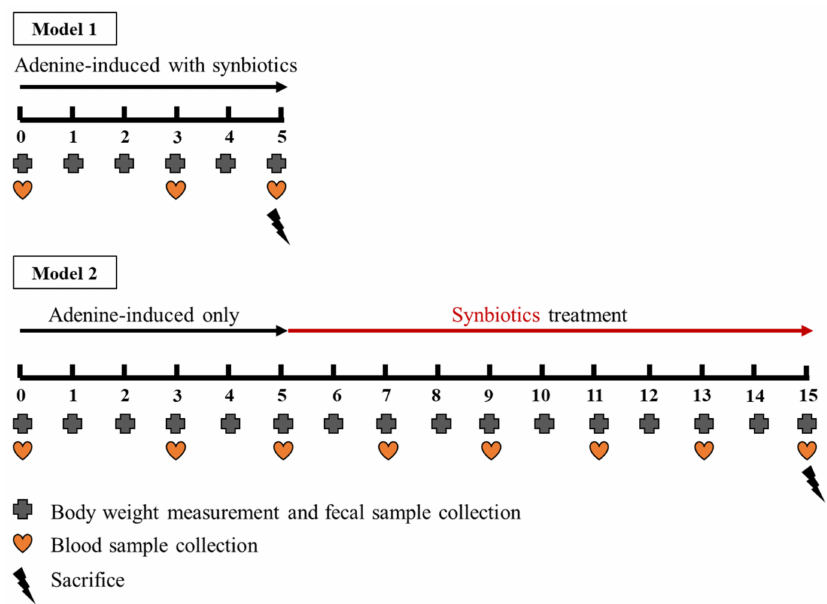
Figure 1. Adenine-induced CKD rat